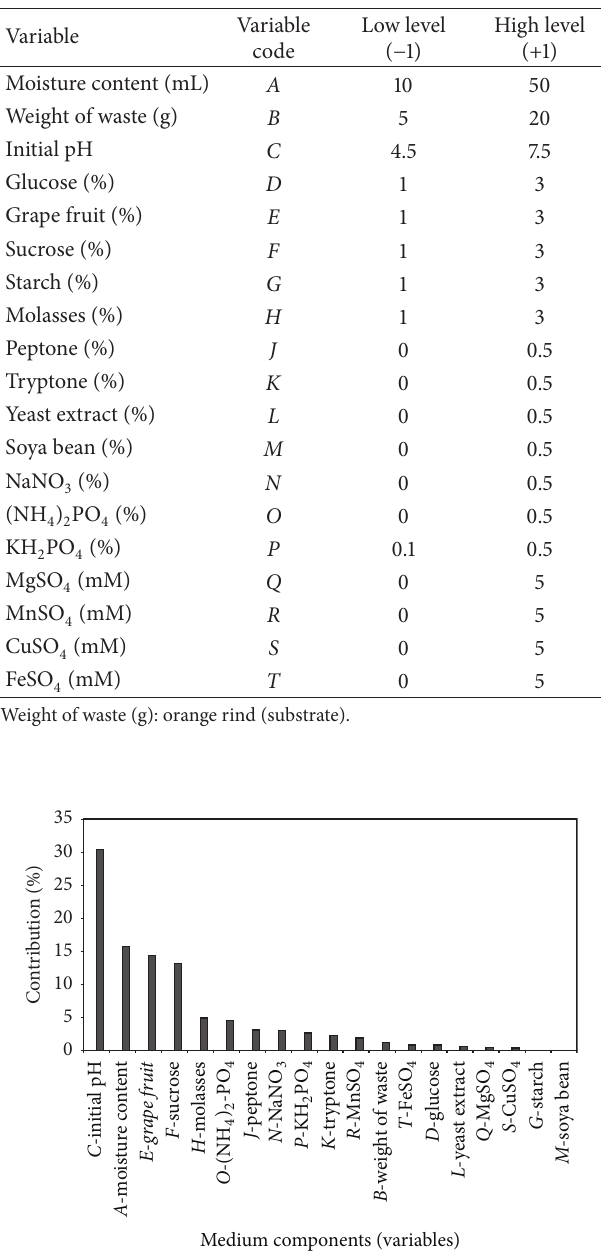
Table 1: Media components and test levels for Plackett–Burman experiment.